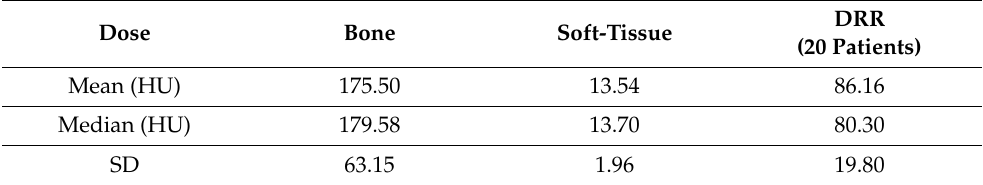
Table 2. HU comparability and DRR comparability between the initial CT scan and the synthetic CT scan (root mean square